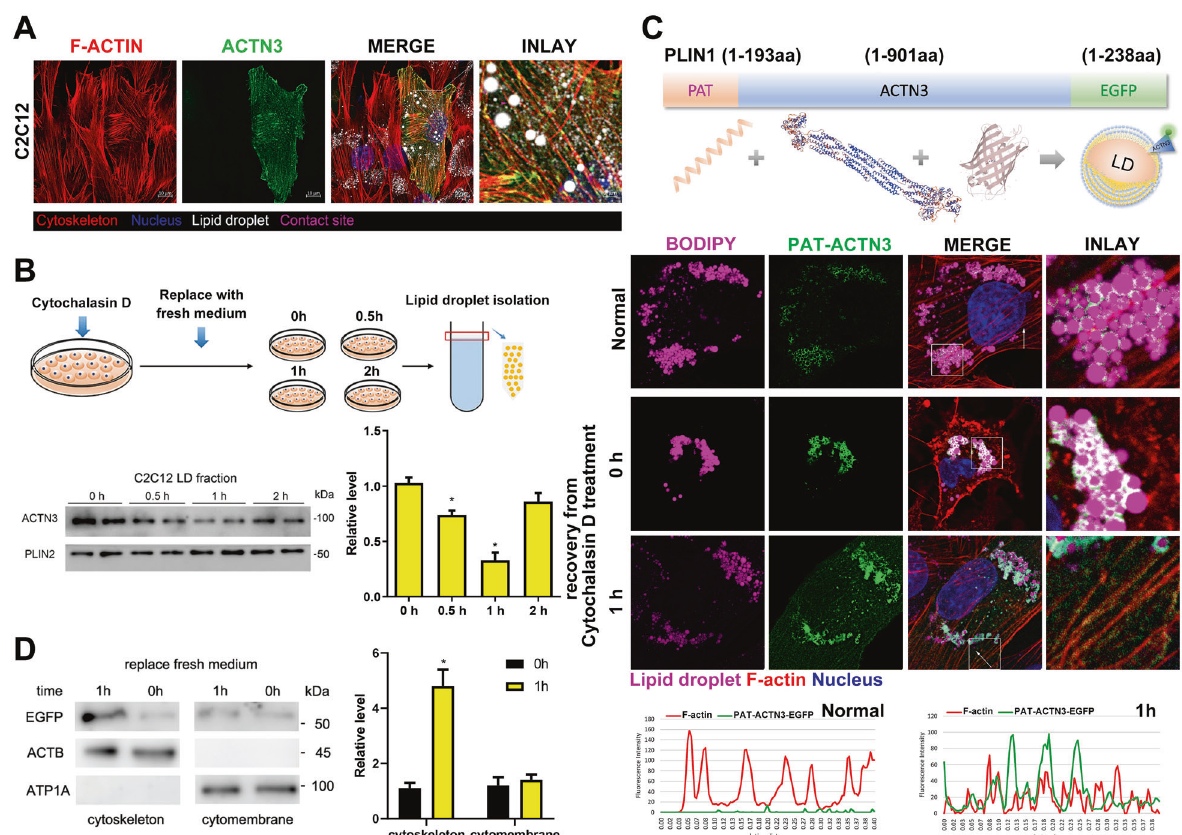
Fig. 5 Transfer of actinin from LD surface to micro fi lament during micro fi lament remodeling. A Co-localization of ACTN3, micro fi laments, and LDs in C2C12 cells. B The C2C12 cells were treated with cytochalasin D for 2 h. Then, the medium was replaced with a fresh medium. The LDs were isolated at 0 h, 0.5 h, 1 h, and 2 h, respectively. The ACTN3 levels were detected by Western blotting. C The LD-targeting ACTN3 plasmid was constructed by inserting a PAT domain (PLIN1 1 – 193aa) at the N-terminus of ACTN3. The co-localization of PAT-ACTN3-EGFP, LDs, and micro fi laments in C2C12 cells was detected by a co-confocal microscope. The fl uorescence intensity, along with the arrow line, is plotted in the below graphs. D The C2C12 cells (expressing PAT-ACTN3-EGFP) were treated with cytochalasin D for 2 h, then the medium was replaced with a fresh medium. The subcellular components were isolated at 0 and 1 h, respectively. The levels of EGFP were detected. ACTB was utilized as the micro fi lament reference protein and ATP1A was utilized as cytomembrane reference protein. * p < 0.05. Results are from three technical repeats ( N = 3) for a representative of three biological repeats ( N =